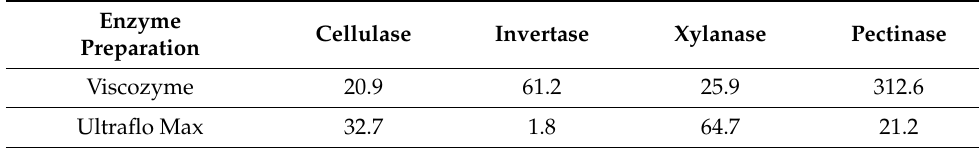
Table 5. Activities of enzymes used in the studies